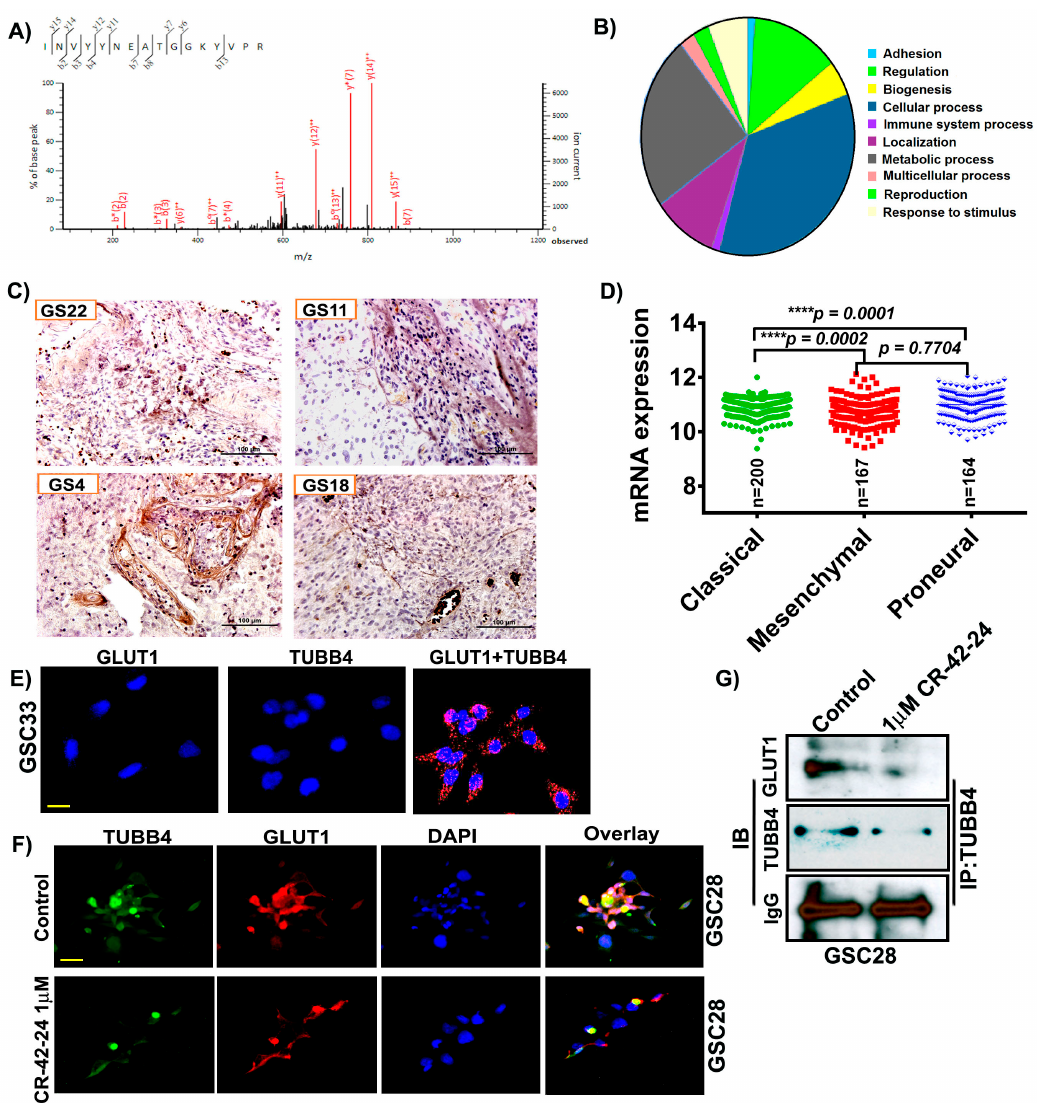
Figure 3. GLUT1 associate and interact with TUBB4 in GSC. ( A ) Around 400 µ g of total protein was extracted from hGBM specimen (GS6-4). The lysates were immunoprecipitated with GLUT1 antibody and the eluates were subjected to LC / MS analysis. LS / MS spectra showed the high relative intensity of reporter ions for TUBB4. The spectra acquisition is mentioned in the methods section. ( B ) Annotation of the spectral data using Pantherdb software. ( C ) Immunohistochemical analysis for TUBB4 using an anti-TUBB4 antibody (brown, diaminobenzidine; light blue, nuclear counter stain with DAPI; GS = glioblastoma specimen). ( D ) TCGA analysis of TUBB4. ( E ) The proximity ligation assay (PLA) confirmed the association of GLUT1 and TUBB4 in GSC33 cells. The representative micrograph of GLUT1 + TUBB4 shows the positive PLA. Red spots confirmed the association. Single antibody stain with TUBB4 and GLUT1 showed negative results. Scale = 10 µ m. ( F ) Immunofluorescence analysis show a TUBB4-GLUT1 association in GSC28 control cells. CR-42-24 treatment diminished their association. Blue = DAPI; red = GLUT1; green = TUBB4; yellow color in the overlay shows the association. Scale = 10 µ m. ( G ) Immunoprecipitation of GSC28 control and 1 uM CR-42-24 treated cells confirmed the interaction of GLUT1-TUBB4. IgG is shown as a loading control.